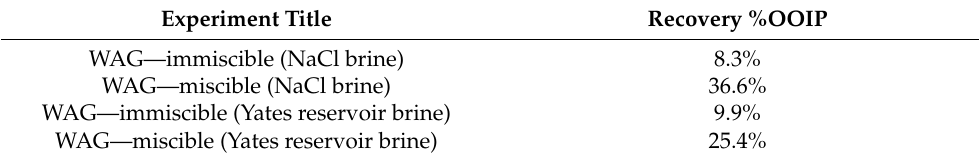
Table 2. Oil recovery comparison between miscible and immiscible WAG injection [102]. Experiment